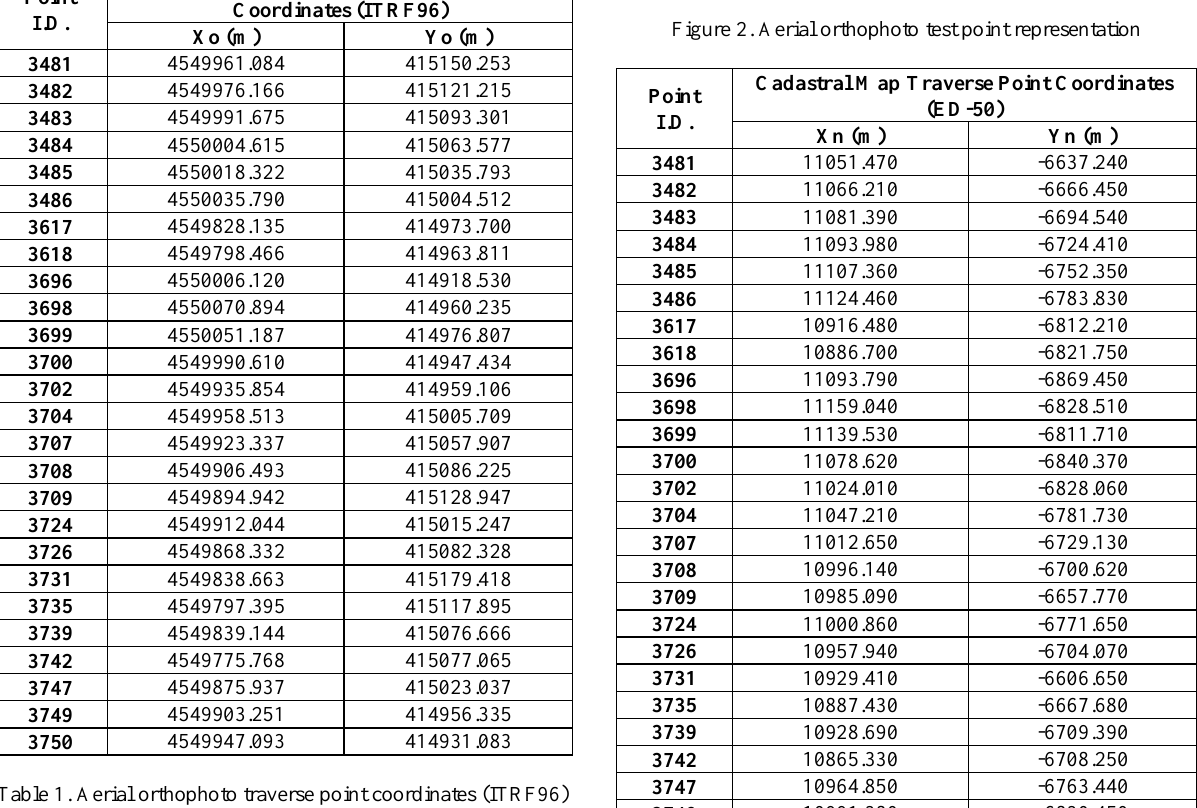
Table 1. Aerial orthophoto traverse point coordinates (ITRF96)